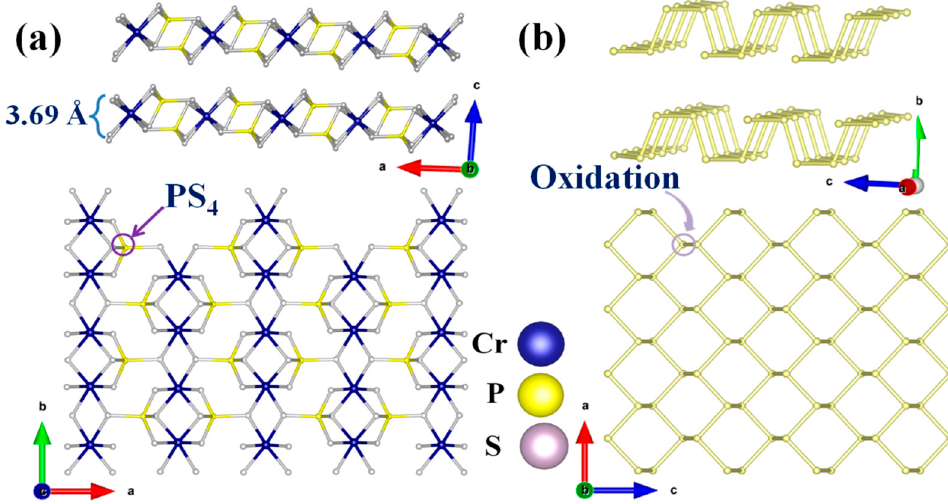
Figure 1. Schematic diagrams of crystal structures of layered ( a ) CrPS 4 and ( b ) BP. (The arrows represent the three coordinate axes of the crystallographic coordinate system.)